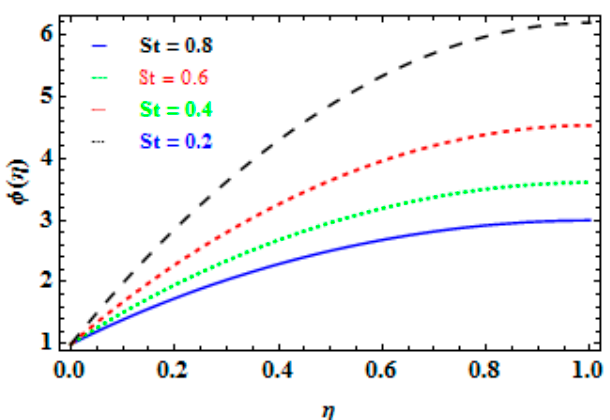
Figure 16. Influence of St on 𝜙 ( 𝜂 ) .